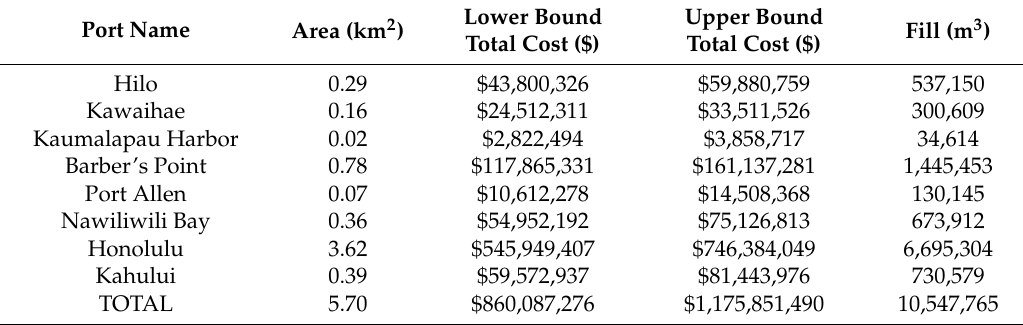
Table A1. Cost and materials required to elevate and retrofit Hawaii Seaports in response to two meters of sea level